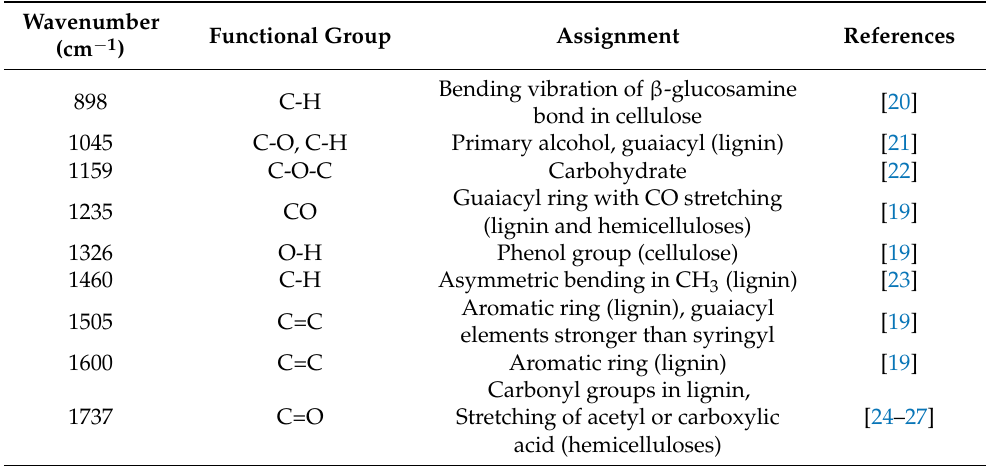
Table 3. Characteristic bands of FTIR spectra of various bamboo specimens in the frequency interval 400 to 1800 cm − 1